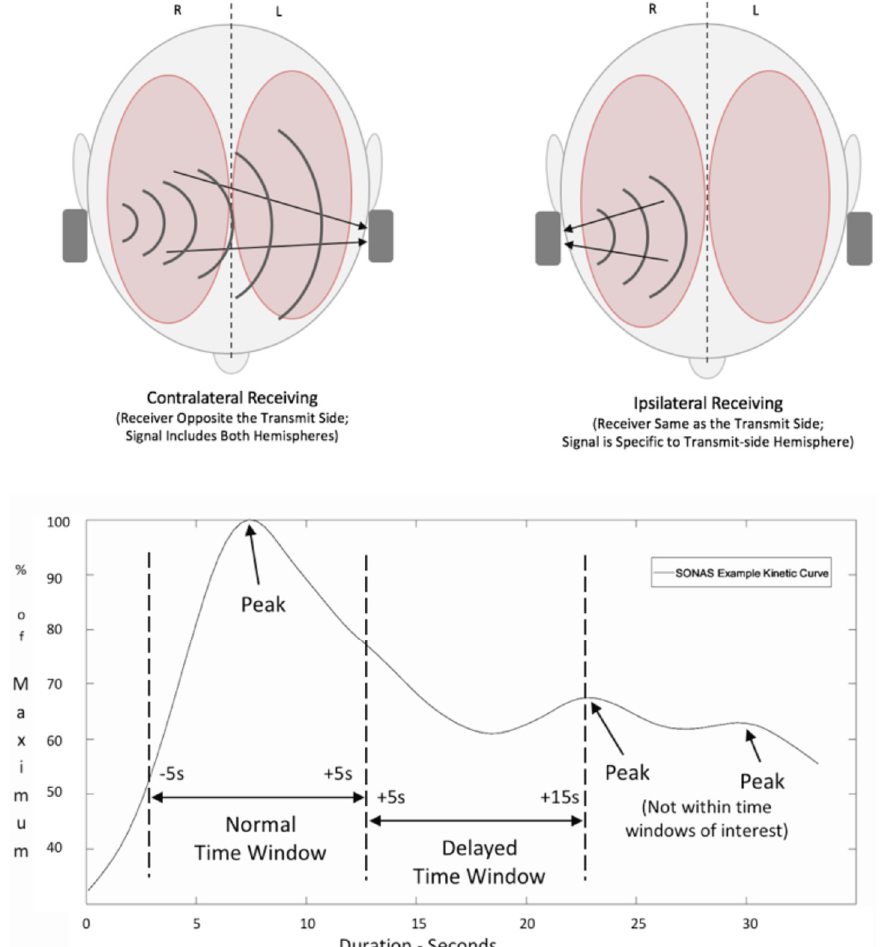
Figure 3. Upper figure: signal transmission and recording from both ultrasound transducers after injection of echo-enhancing agents demonstrating the mode of operation. R—right, L—left. Lower figure: time intensity curves after contrast agent injection with X-axis time after injection and Y-axis maximum signal backscatter analyzed automatically by BPU machine (SONAS ® ). The first peak is due to the first appearance of contrast agent while the second and third peaks are to due systemic reflow phenomenon.